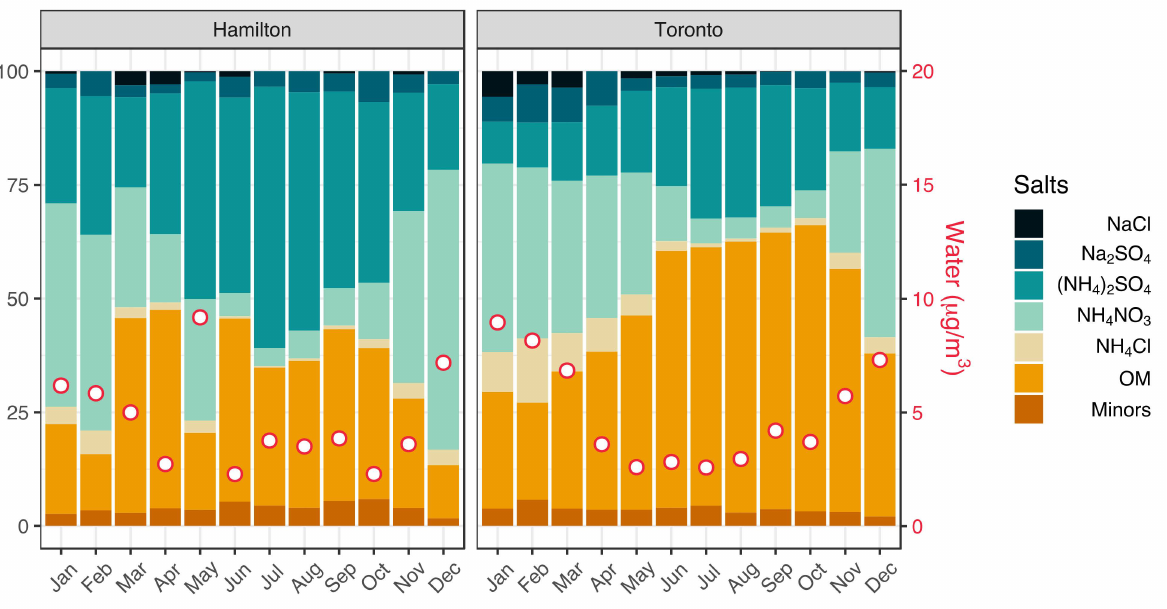
Figure 3. Monthly average of aerosol Liquid water content (LWC) in Hamilton ( left ) and Toronto ( right ) expressed as a percentage of water content speciation per chemical salt contained in the particulate phase (right y -axis); absolute aerosol LWC express in µ g m − 3